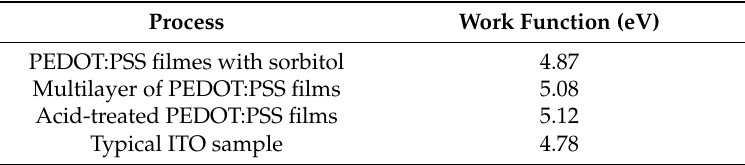
Table 2. Work function of PEDOT:PSS films spin cast with different processes.